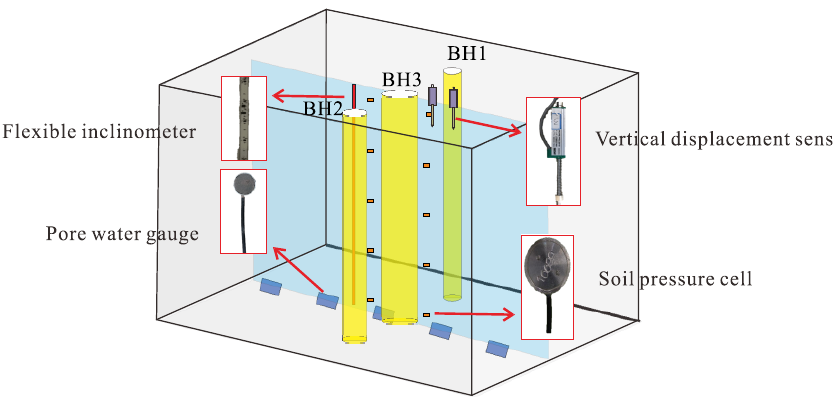
Figure 7. Three-dimensional schematic diagram of instrument layout around BH3.